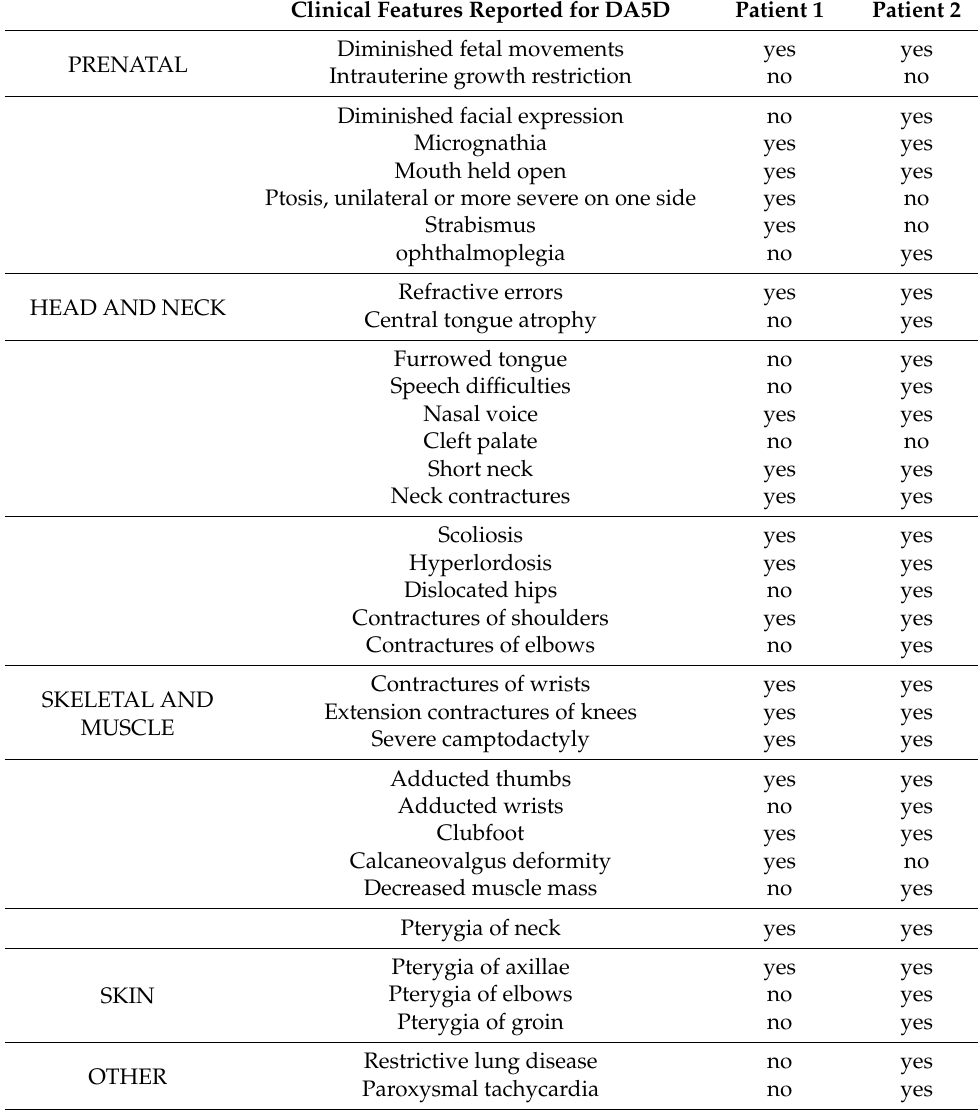
Table 1. Clinical